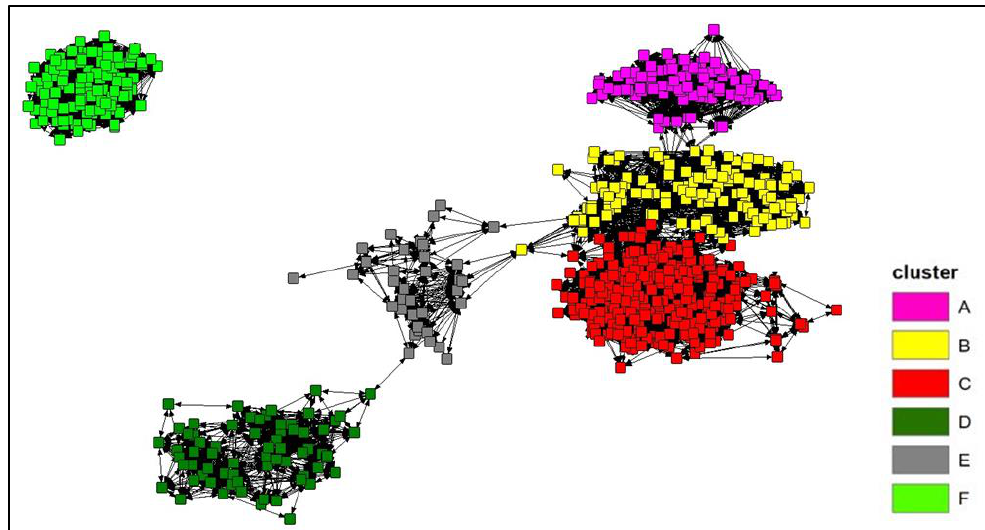
Figure 5. The connectivity network of the photo-identified bottlenose dolphins with at least four captures (703 individuals) according to the Spring embedding lay out. A Girvan–Newman analysis was performed to identify the clusters within the network according to the betweenness of the bonds (see the different colours).